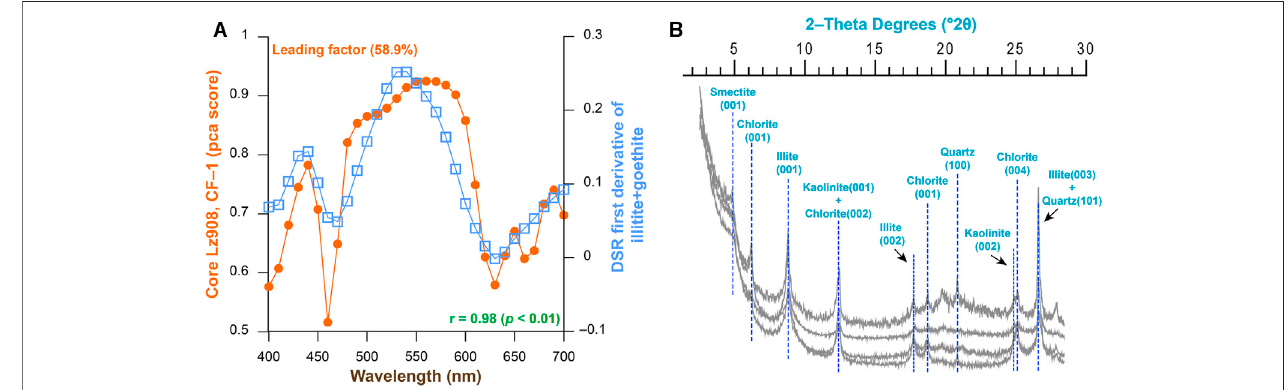
FIGURE 3 | (A) Varimax – rotated factor loadings of core Lz908 and DSR fi rst derivates of mineral standards (Illitite + Goethite) plotted as a function of wavelength; (B) Four representative samples for XRD analysis with the identi fi ed minerals.